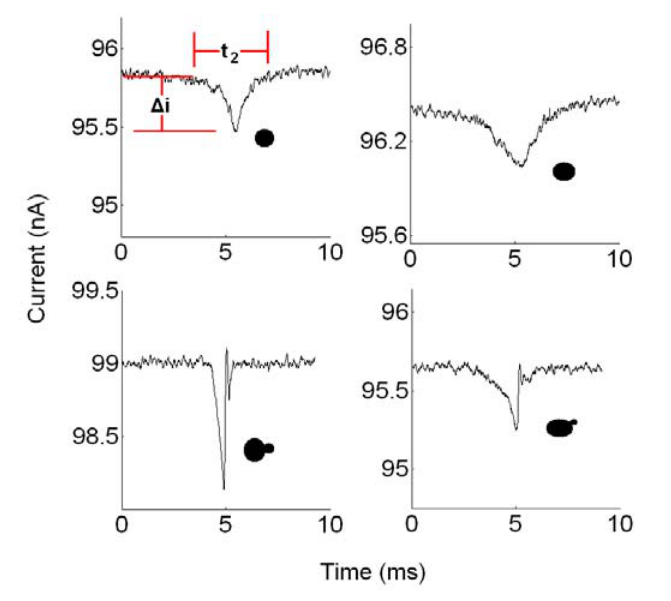
Figure 7. Typical current signatures observed. (a) Two examples of single yeast translocation events recorded using a 10 µm diameter pore. Events are characterized by their individual translocation times, t , and current amplitudes, Δ i . (b) Two examples of 2 budding yeast cell translocations. The inset in both (a) and (b) is an illustration of the probable morphology of the translocating yeast